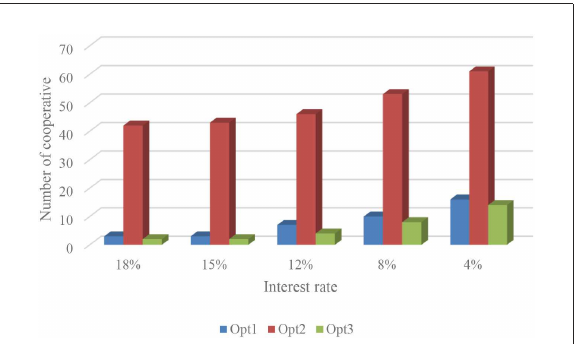
FIGURE4 The amount of participation of farmers with optimal water allocation patterns by using the policy of granting facilities.